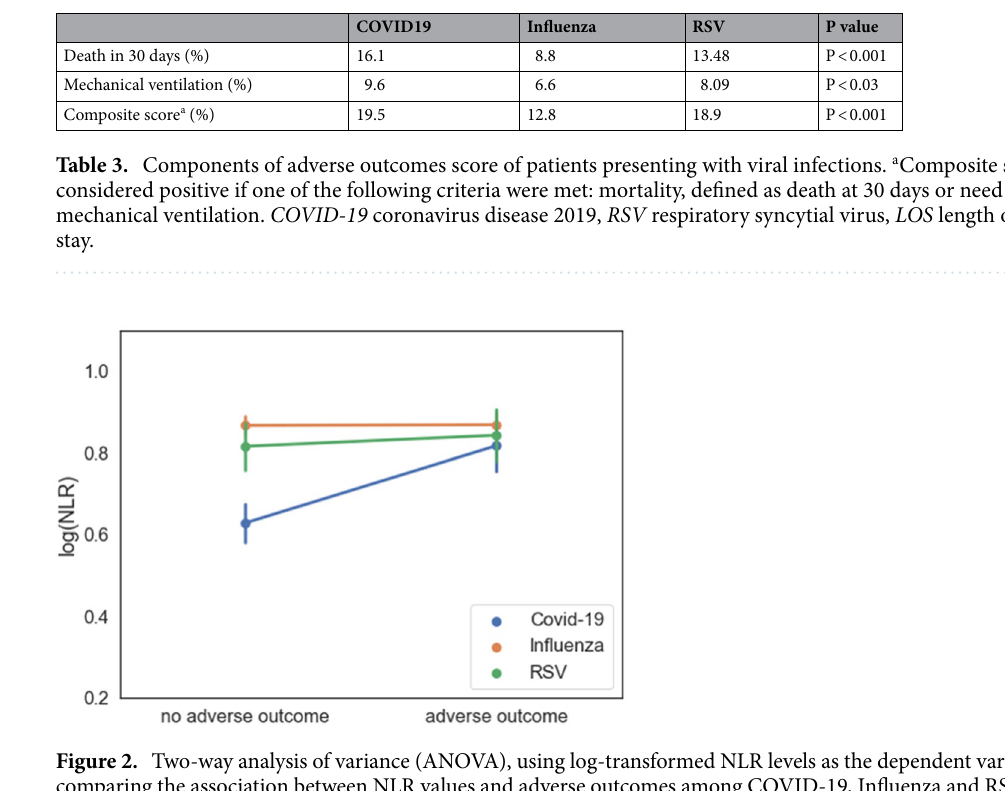
(Fig. 3). The area under curve (AUC) of poor outcomes for COVID-19, Influenza and RSV was 0.68, 0.57 and 0.58, respectively. The optimal cutoff of NLR for COVID-19 was obtained from Youden’s index: NLR of 6.82. We did not further analyze the other group’s ROC curves because of the low AUCs. Multivariate logistic regression was used in order to test the discrimination ability of NLR (above or below 6.82) as a prognostic factor of poor clinical outcome adjusted for age, sex and Charlson score. Results showed an odds ratio (OR) of 2.88 for NLR > 6.82 (P < 0.001) and a total AUC of 0.79 (Fig. 4). In this model age had an OR